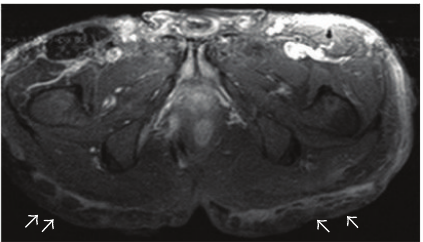
Figure 9: Axial T1-weighted fat-suppressed image postintravenous Magnevist: this MRI image done at the patient’s first presentation 9 years ago shows multiple rim-enhancing subcutaneous abscesses in bilateral gluteal regions (white arrows) without deep extension or significant dermal induration, consistent with the early course of the